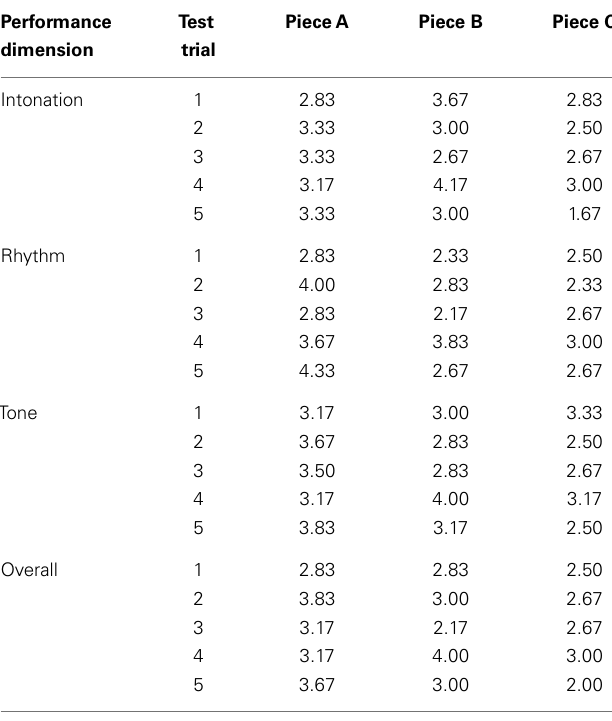
Table 6 | Mean performance ratings for all evaluated performance dimensions according to piece and test trial